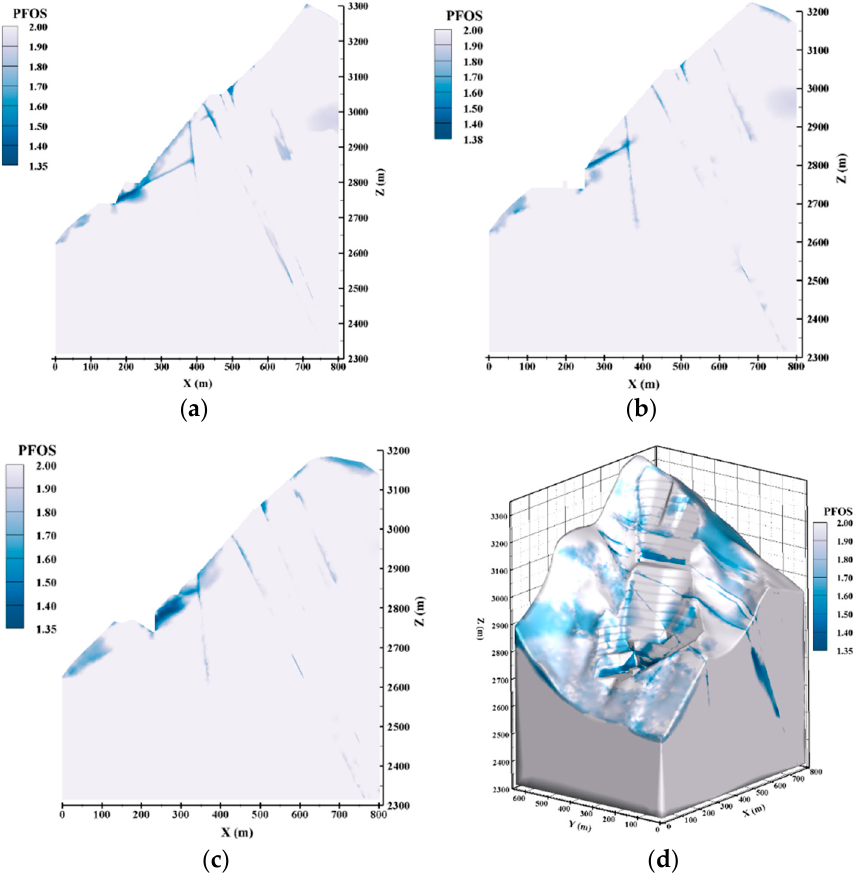
Figure 11. Point factor of safety distribution of slope under condition III. ( a ) Profile 5; ( b ) profile 10;